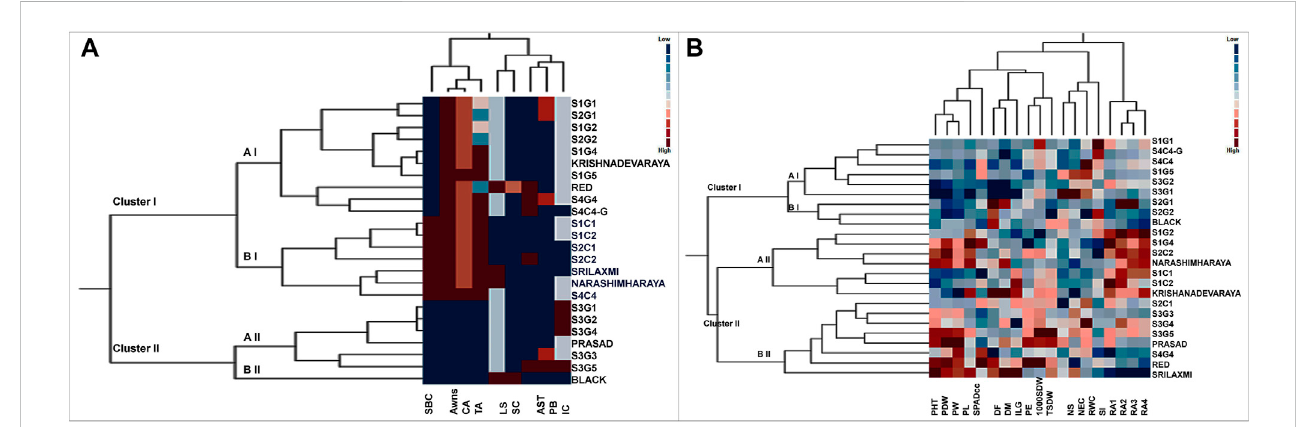
FIGURE 5 Two way cluster analysis for (A) qualitative and (B) quantitative traits in twenty foxtail millet landraces along with four released cultivars. Two way cluster analysis constructed double dendrograms, on the vertical direction, fi rst dendrogram represent genotypes and horizontal direction second dendrogram representing traits. Colored bars indicated in the two-way cluster corresponding to the trait mean data.